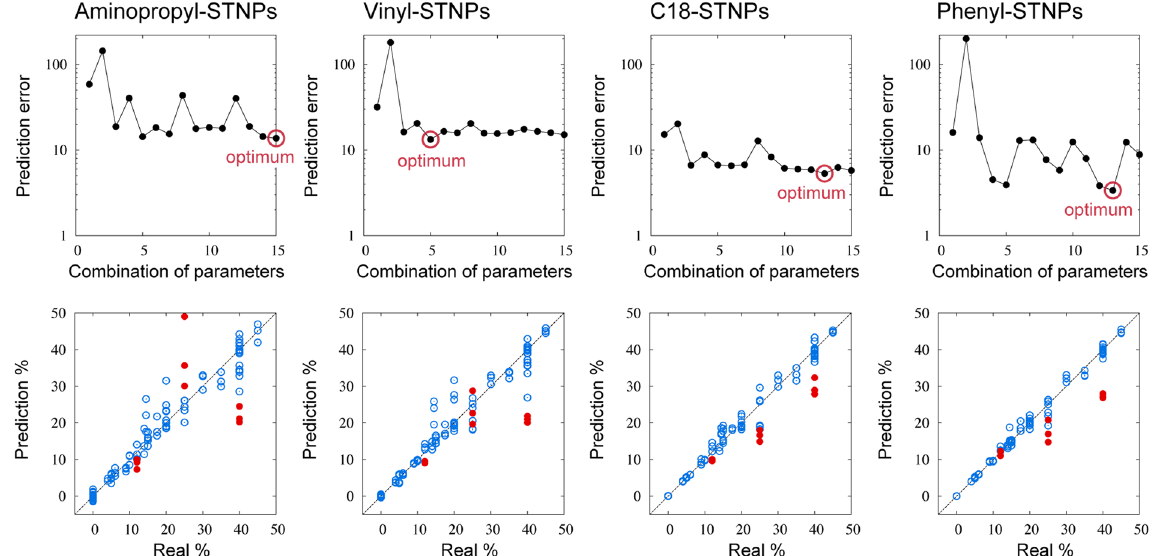
Figure 9. (Top) Prediction errors depending on the combination of four parameters extracted from a signal under an ambient condition. The combination of parameters is labeled by the decimal number. In the binary representation of the decimal number, the 1st digit bit corresponds to the use of parameter 1 (0: “not used”, 1: “used”); same for 2nd, 3rd, and 4th digit bits for parameters 2, 3, and 4, respectively. For example, the number of the combination of parameters 13 corresponds to 1101 in the binary representation, meaning that the parameters 1, 3, and 4 are used. (Bottom) Parity plot of predicted alcohol content versus real alcohol content under an ambient condition. The blue points represent the known liquors which are used to train the ML model. The red points are the unknown liquors: red wine (12%), imo-shochu (25%), and whisky (40%).